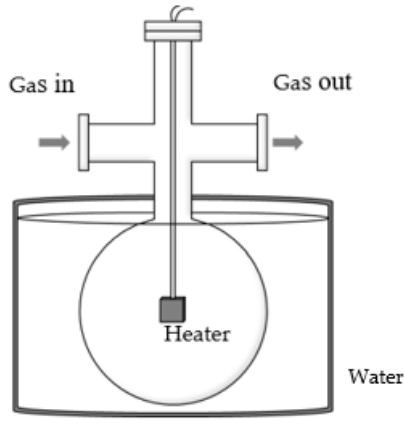
Figure 2. A schematic of the experimental setup.